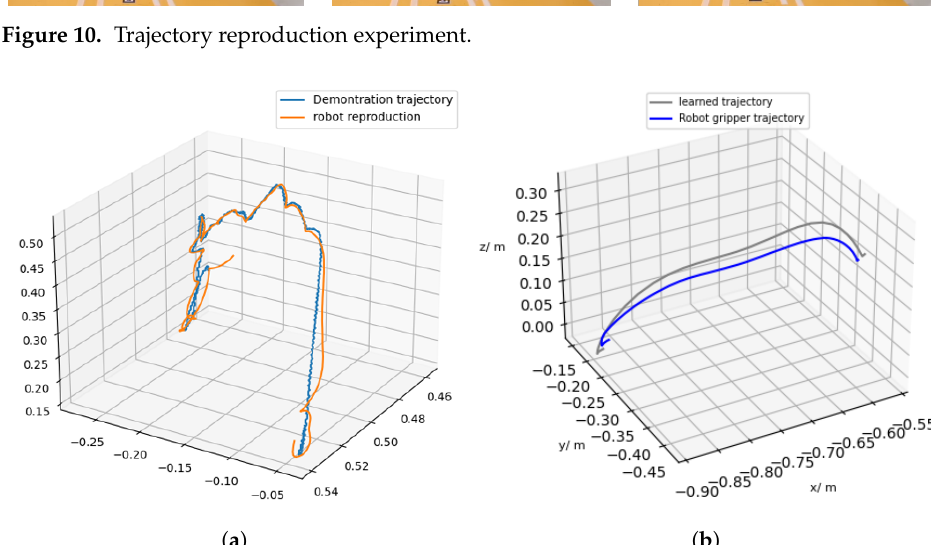
Figure 11. Trajectory reproduction results. ( a ) Trajectory reproduction from a single demonstration in previous work [18]. ( b ) Trajectory reproduction from a learned trajectory based on